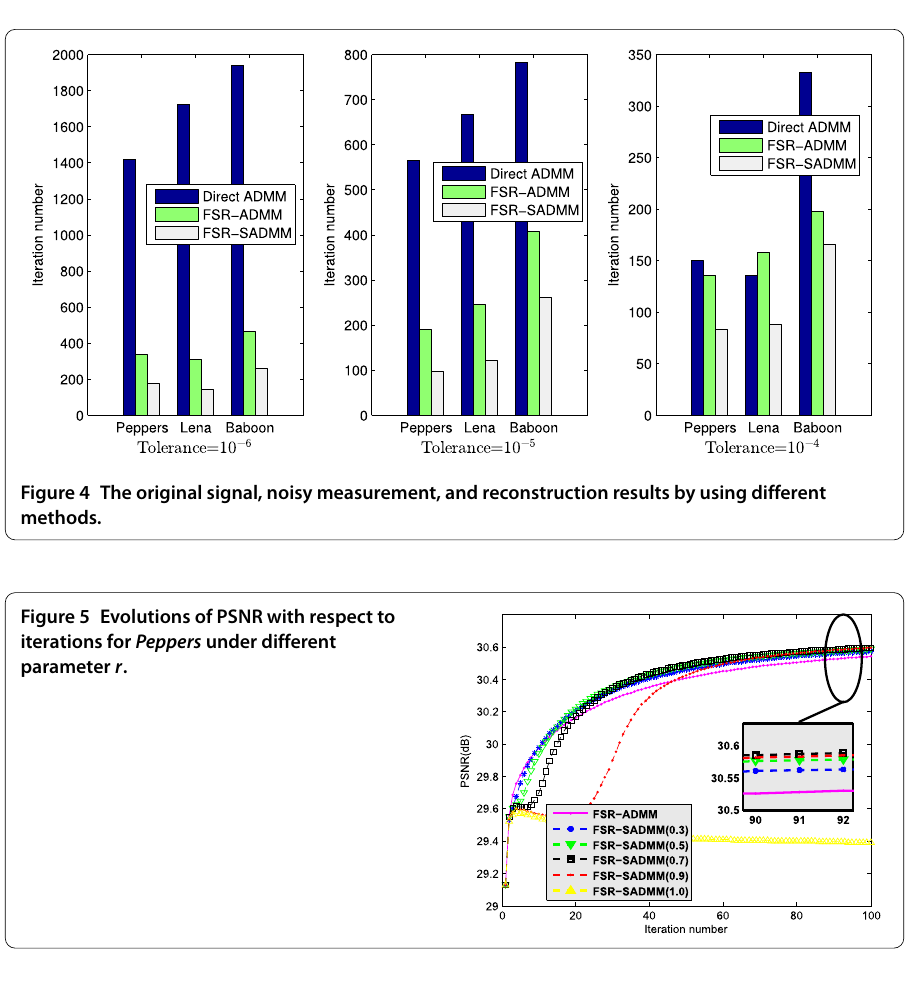
Table 1 The performance of different SADMM-type algorithms in terms of PSNR and SSIM Tolerance